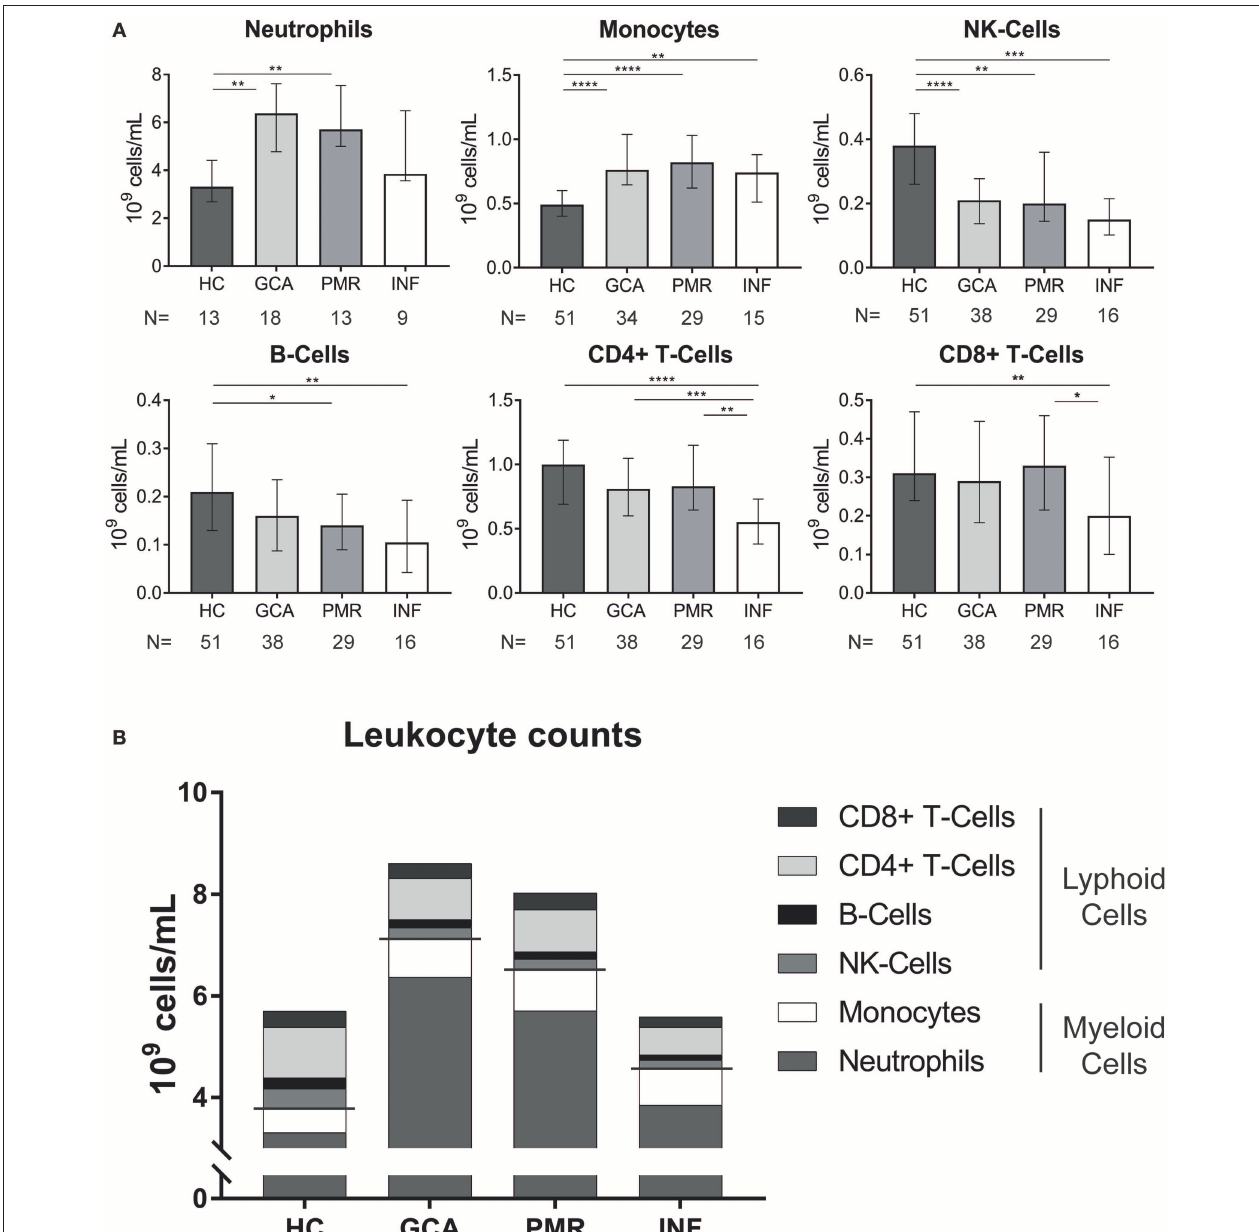
FIGURE 1 | Pre-treatment measurements in newly-diagnosed, treatment naive GCA and PMR patients. (A) , Leukocyte counts in the blood for GCA and PMR as well as two control groups: HC and INF. The n is depicted in the figure and indicates the number of samples measured in the different groups. Data is expressed as median and interquartile range. Statistical differences by Mann Whitney U between groups are displayed if Kruskal Wallis testing indicated significant differences: * p < 0.05, ** p < 0.01, *** p < 0.001,**** p < 0.0001. (B) , Stacked leukocyte subset counts show a clear shift to the myeloid lineage in GCA and PMR pre-treatment.